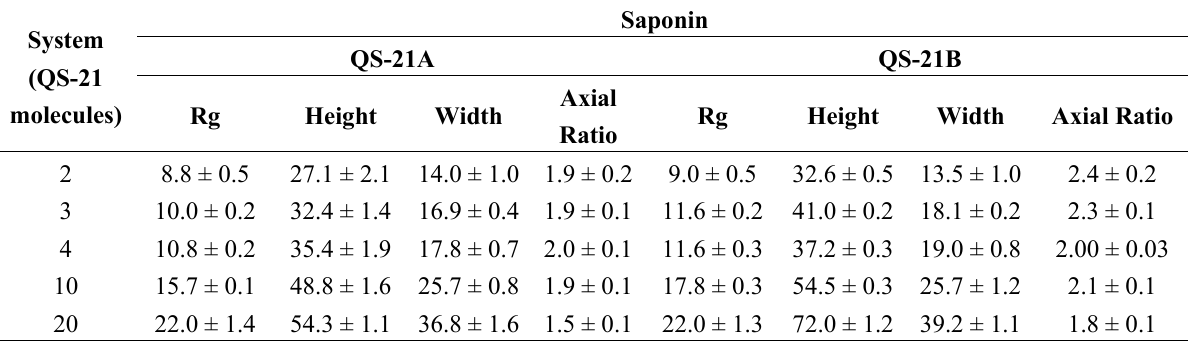
Table 1. Dimensions (radius of gyration, height and width) of the assembled micelles for each MD simulation of QS-21A and QS-21B. All values are given in Å.